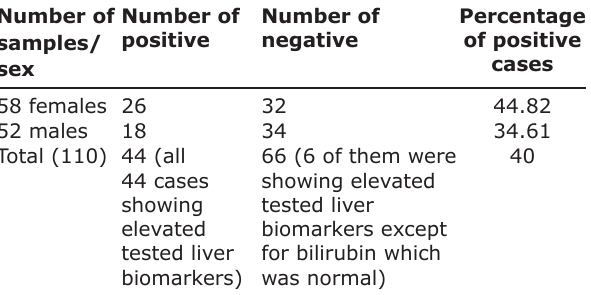
Table-1: General incidence rate (%) of Fasciola infection in examined cattle according to coprological examination. Number of samples/